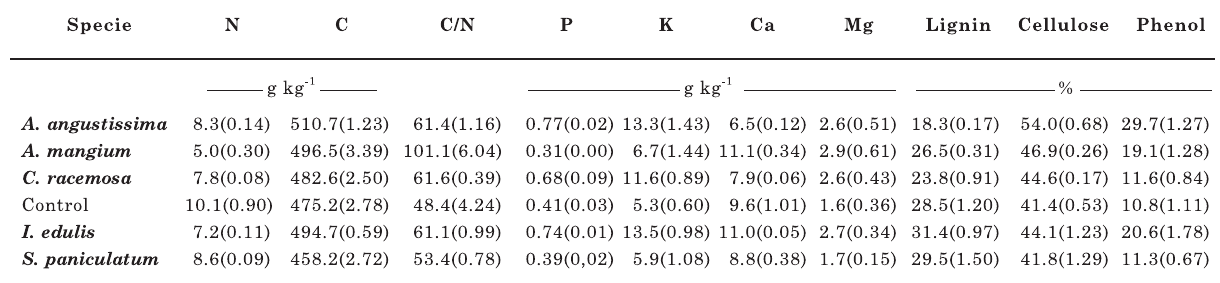
Table 1. Initial chemical composition of litterbag material from different leguminous species and control (fallow vegetation) used in the decomposition experiment. Average(stand